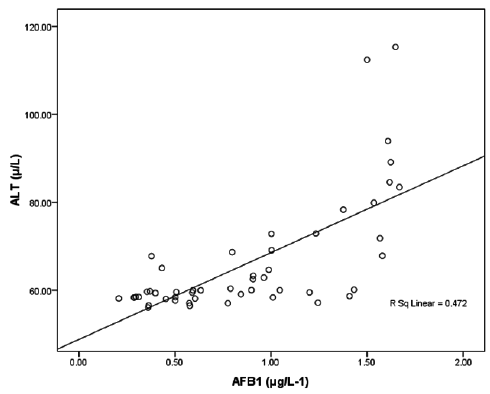
Fig. 2. Correlation between AFB1 (µg/L-1) and ALT (µ/L) with best fit line curve (positive correlation)